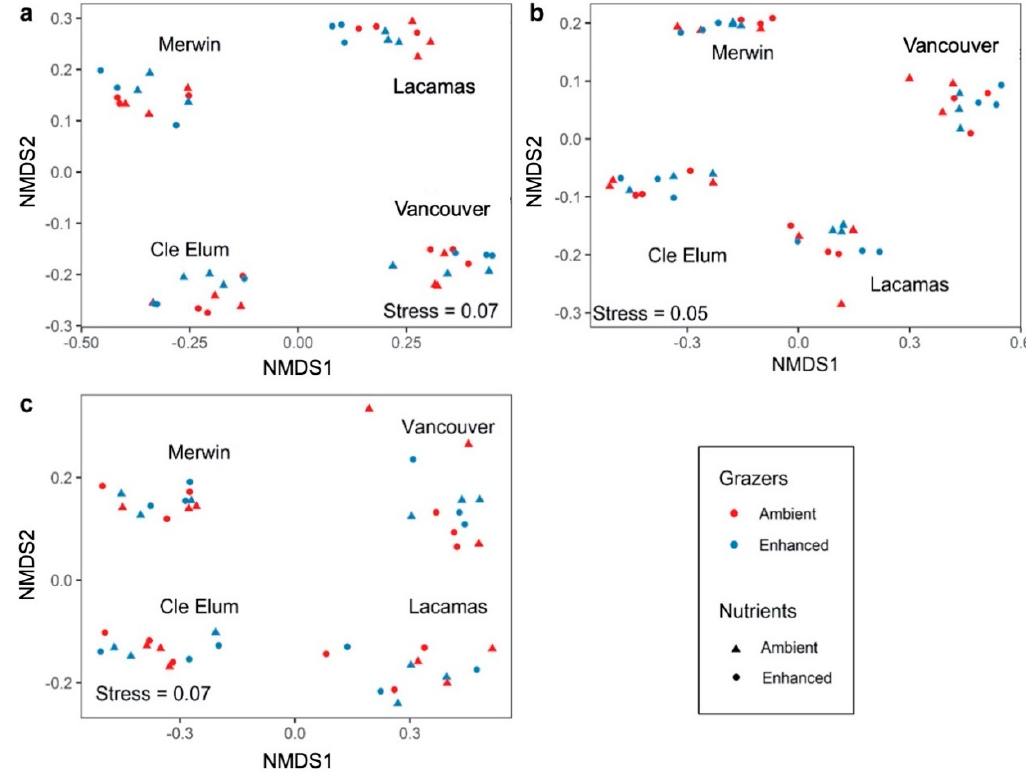
Figure 8. Non-metric Multidimensional Scaling ordinations examining relationships of microplankton assemblages resulting from factorial experiments (i.e., enhanced grazers, enhanced nutrients, and their interaction) conducted in each study system in June ( a ), August ( b ), and October ( c ), as tested by nested two-way PERMANOVA.